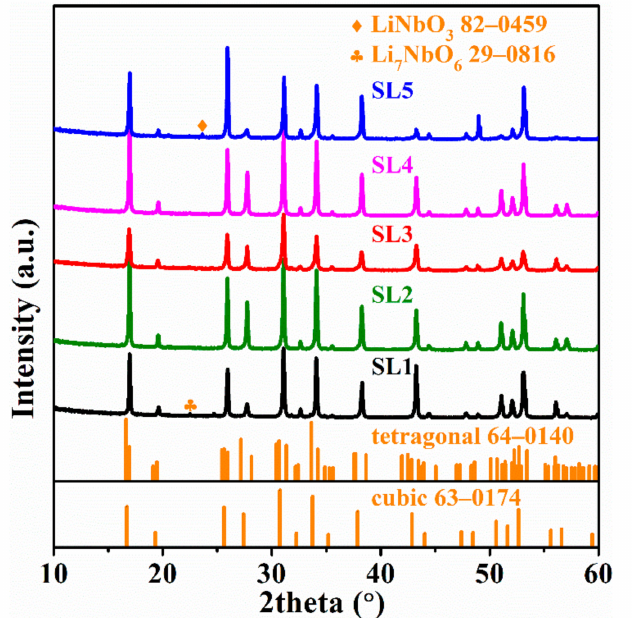
Figure 3. XRD patterns of the LLZNO ceramics with di ff erent sintering